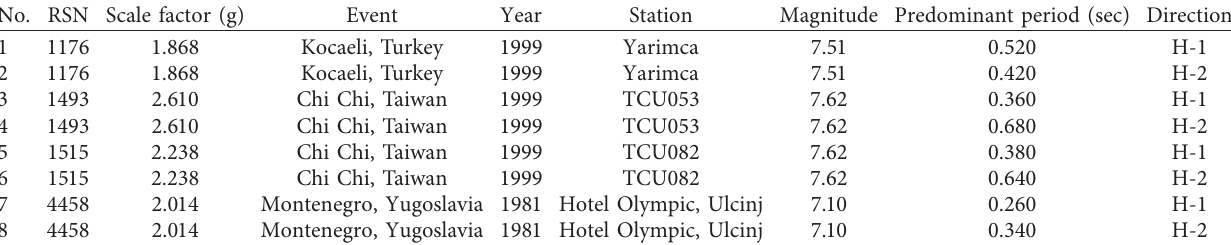
Table 1: Selected near-fault mainshock records.